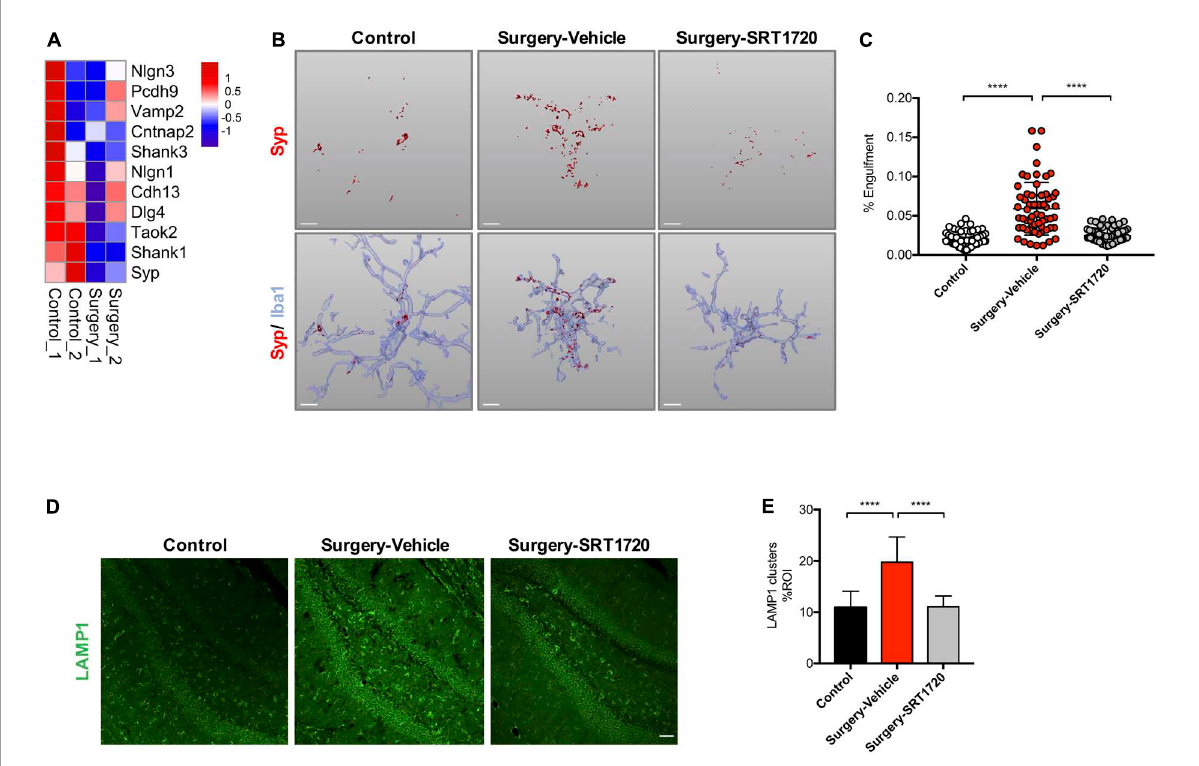
FIGURE5 SIRT1 overexpression ameliorates microglia engulfment of presynaptic inputs after surgery. (A) Heatmap of synaptic protein related gene expression. (B) Representative 3D reconstruction and rendering of Syp signals inside Iba1 + microglia from each experimental group. Scale bar, 5 µ m. (C) Quantification of panel B , n = 5 per group; 10–15 cells per mouse were quantified. (D) Maximum z projections showing LAMP1 in the dentate gyrus of hippocampus from each experimental group. Scale bar, 50 µ m. (E) Quantification of panel D , n = 5 per group. One-way analysis of variance (ANOVA) with Tukey post-hoc test. Data are shown as mean ± SD. **** p < 0.0001. Syp,